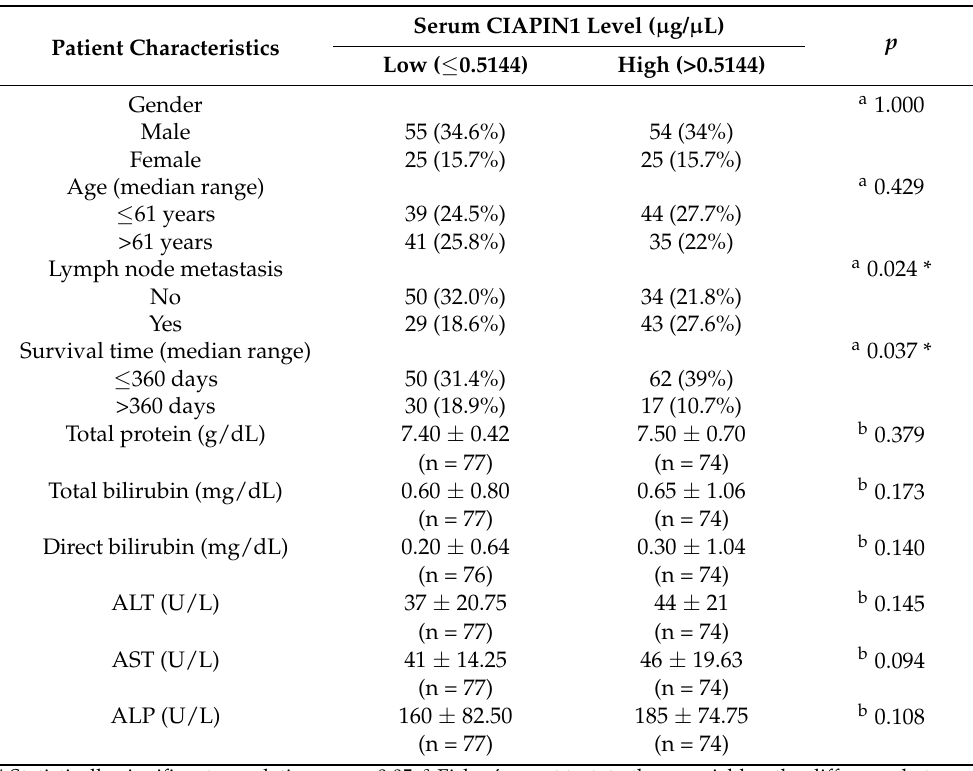
Table 2. Correlations between clinicopathological features and serum CIAPIN1 levels of CCA pa-